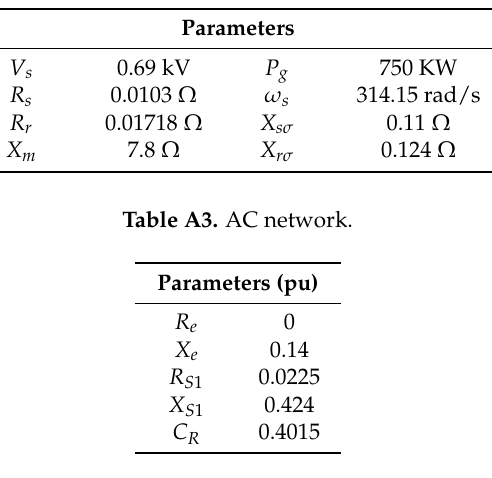
Table A2. Induction generator.